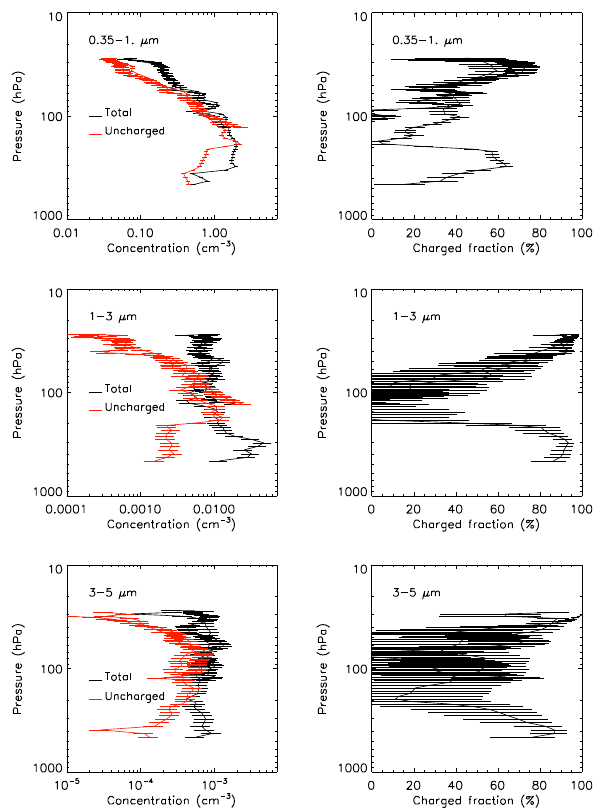
Fig. 2. Left: vertical profiles of integrated concentrations for all the aerosols (“total”) and for the uncharged aerosols, during the balloon ascent and the descent, for the 3 size classes. Right: percentage of charges aerosols for the 3 size classes during ascent and descent, taking into account the errors bars on concentrations (a sliding smoothing is applied to suppress small length-scale